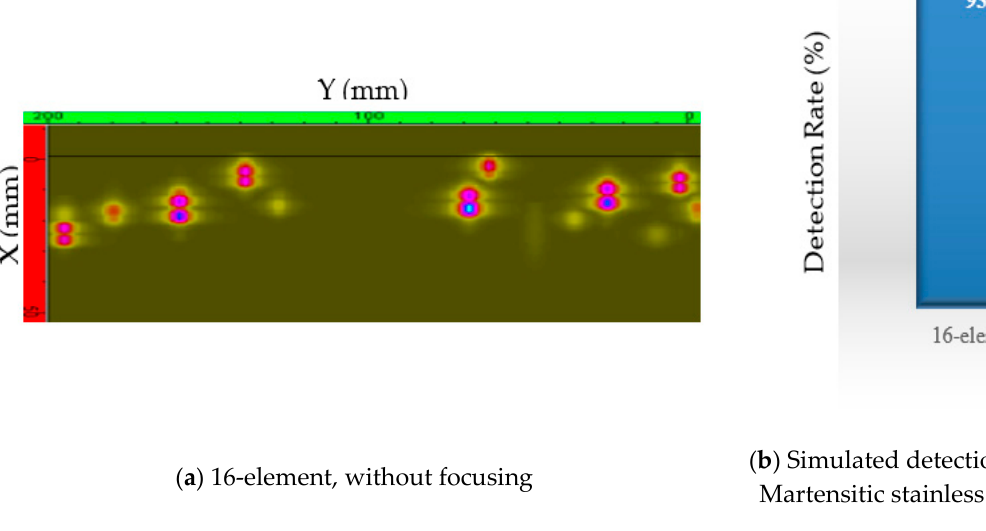
Figure 12. Simulation results from PAUT probe.